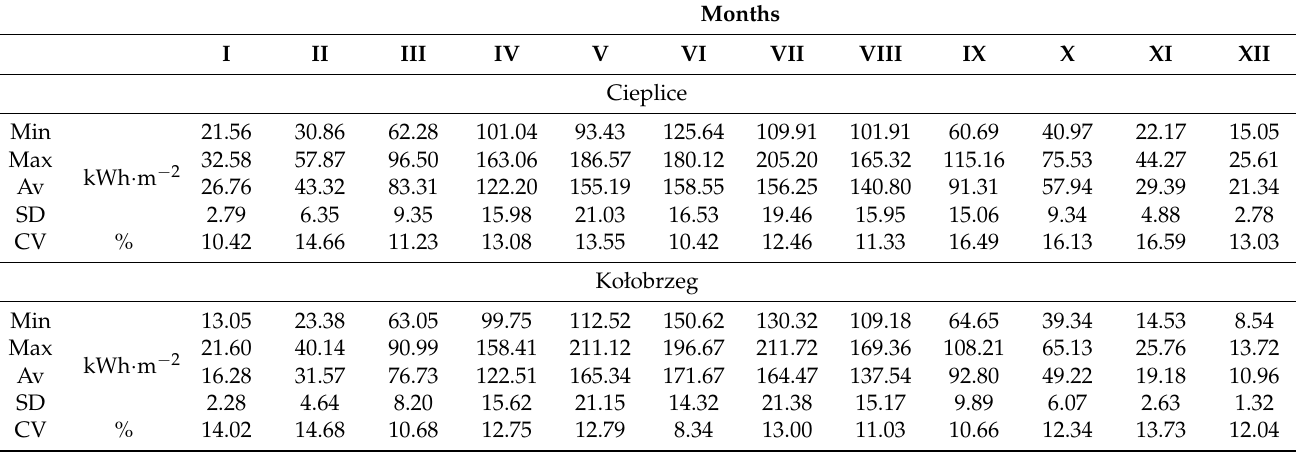
Table A1. Selected statistical characteristics of monthly sums of global solar radiation in Cieplice and Kołobrzeg. Data for the years